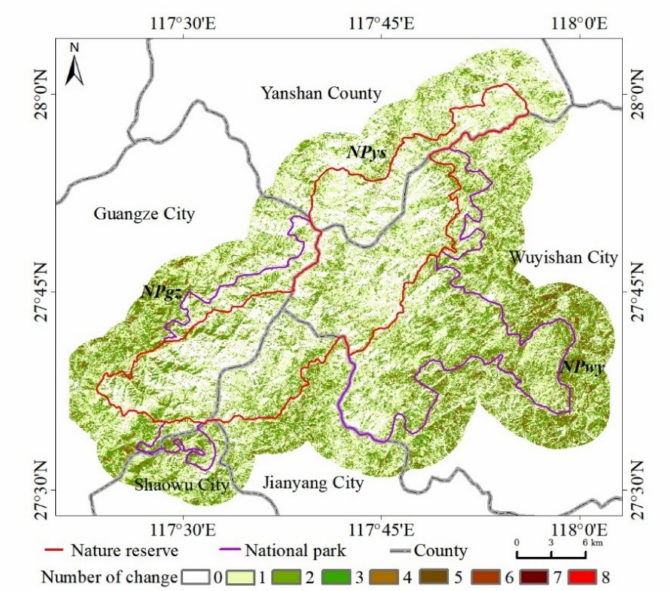
Figure 4. The number of change times between 1986 and 2020 in the study